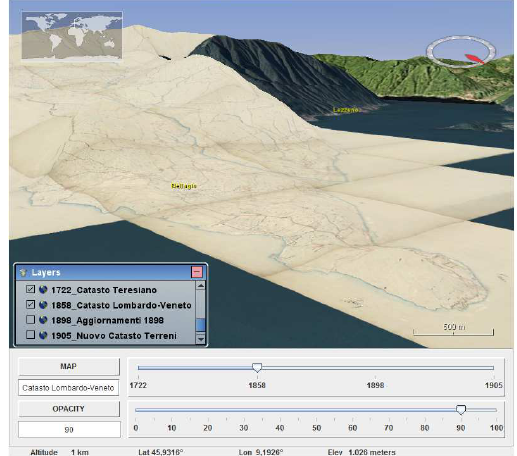
Figure 1. 3D visualization of a historical cadastral map selected through the temporal slidebar